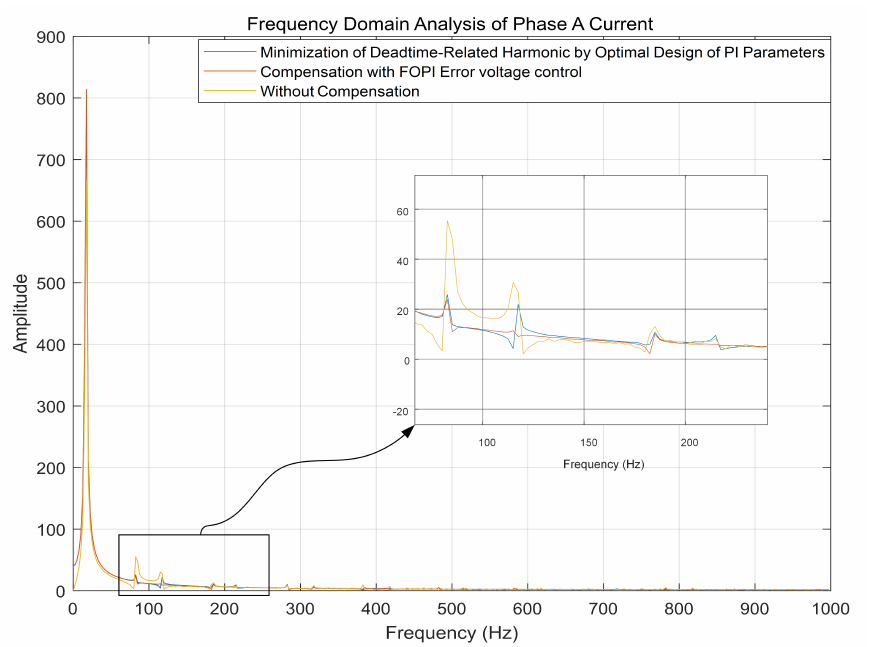
Figure 19. Frequency domain simulation analysis of A phase current under 200 r/min speed conditions.